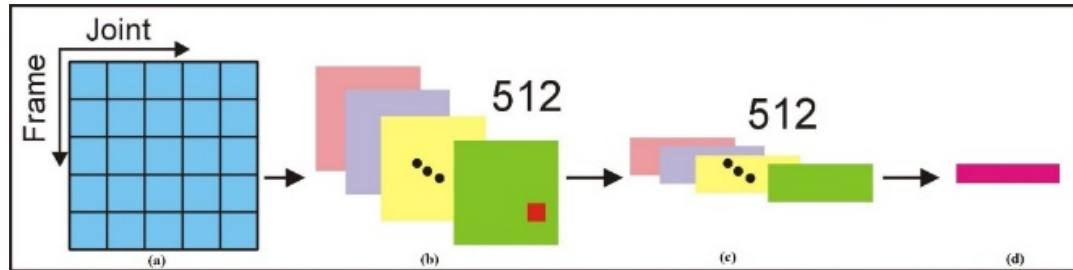
Figure 2. ( a ) An input frame created from a skeleton sequence, with columns parallel to the different vectors created from the joints and the rows, similar to the various structures of the skeleton sequence, for which the columns are parallel to the multiple vectors created from the joints and the rows are parallel to the different frames of the skeleton sequence. ( b ) Output feature maps of the conv8_1 layer (size: 28 × 28 × 512). ( c ) All joints in the skeleton sequence have temporal features, which are obtained by applying mean pooling to each feature map in the row. ( d ) The output feature is obtained by integrating all feature maps in the dataset ( c ).